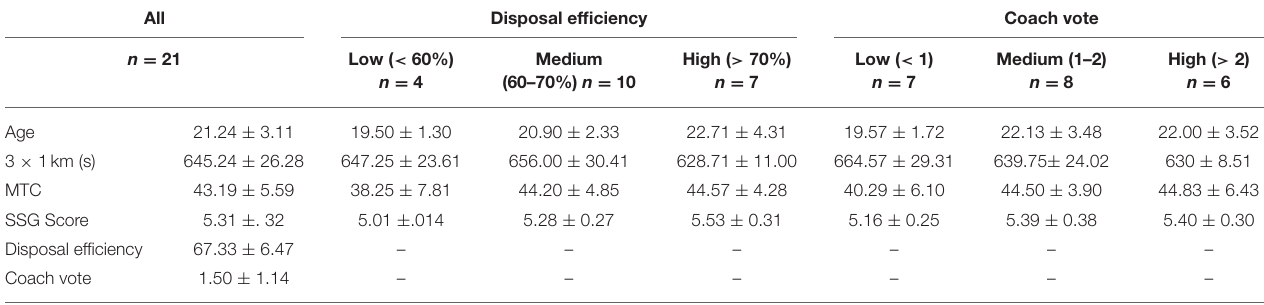
TABLE 4 | Mean sub-discipline scores for participants who completed all tests.